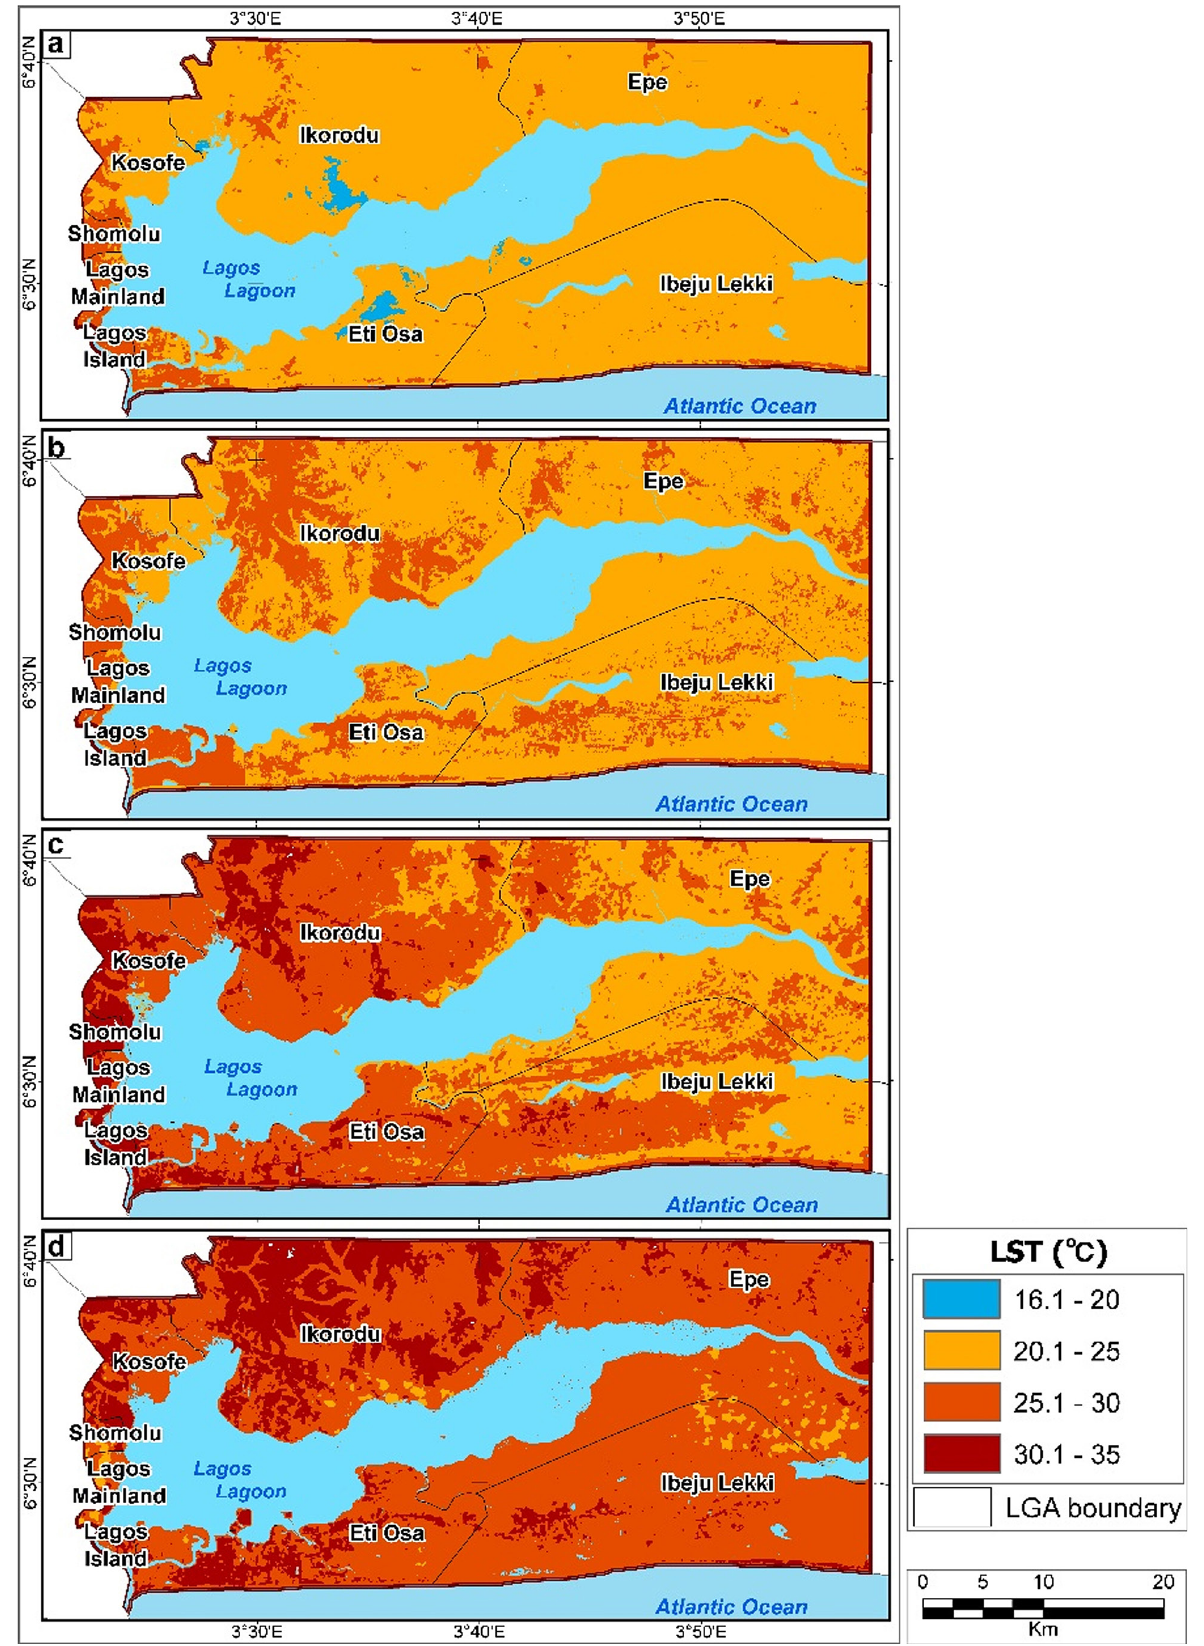
Fig. 5. Spatial pattern of LST for 1984 (a), 2002 (b), 2013 (c) and 2019